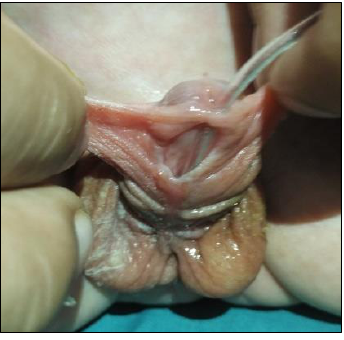
Figure 1: Urethrocutaneous